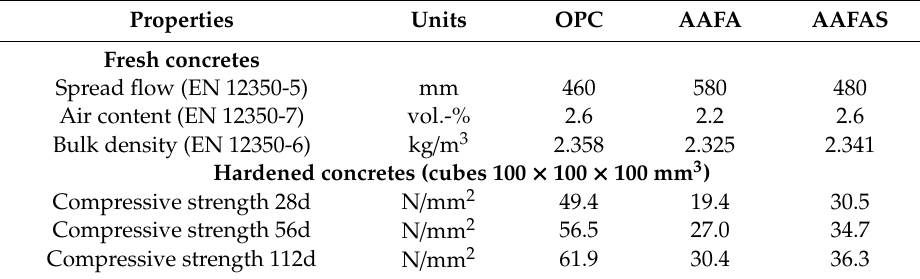
Table 3. Properties of the